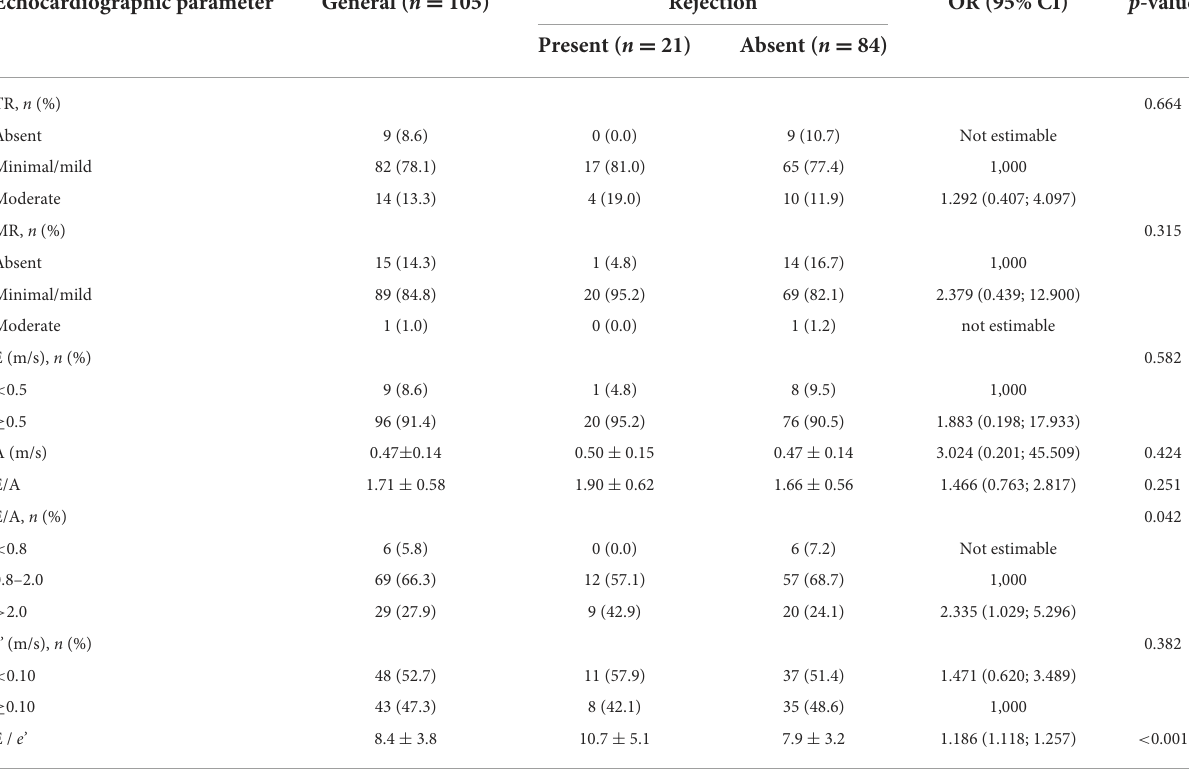
TABLE 3 Conventional echocardiographic parameters obtained by Doppler assessment (pulse-wave, continuous-wave, color and tissue) according to rejection. Echocardiographic parameter